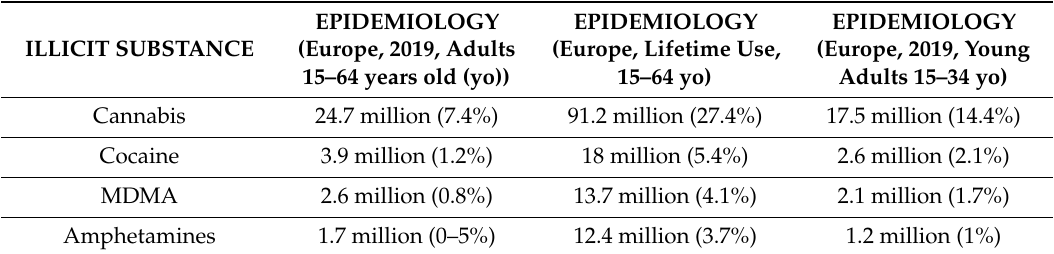
Table 2. Epidemiological data concerning the use of illicit substances from the European Drug Report 2019 by European Monitoring Centre for Drugs and Drug Addiction (EMCDDA)